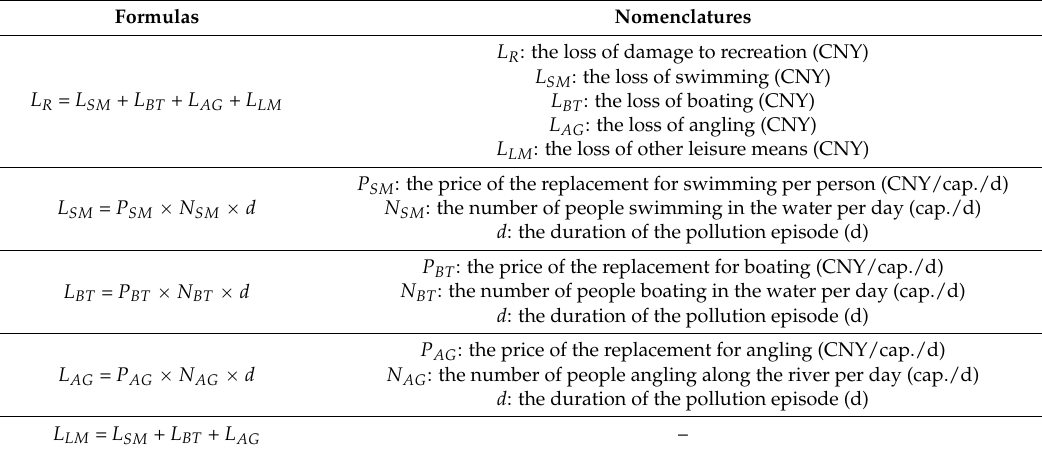
Table 4. The formulas and details in the loss valuation of recreational